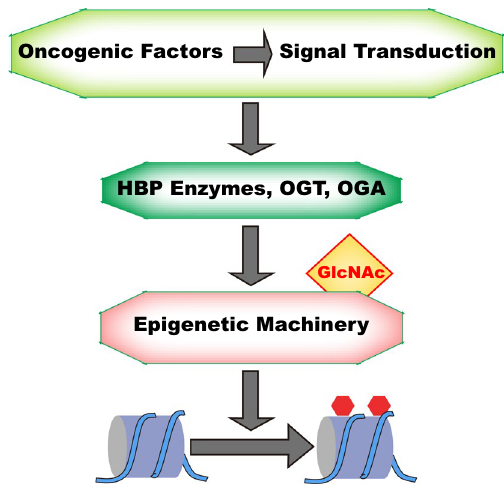
Fig. 2 Oncogenic signal/O- GlcNAcylation/Epigenetic Modification Axis. Virus Oncoproteins and Tumor microenvironmental factor can regulate HBP enzymes and OGT/OGA directly or indirectly through intracellular oncogenic signals. Conse- quently, abnormality in